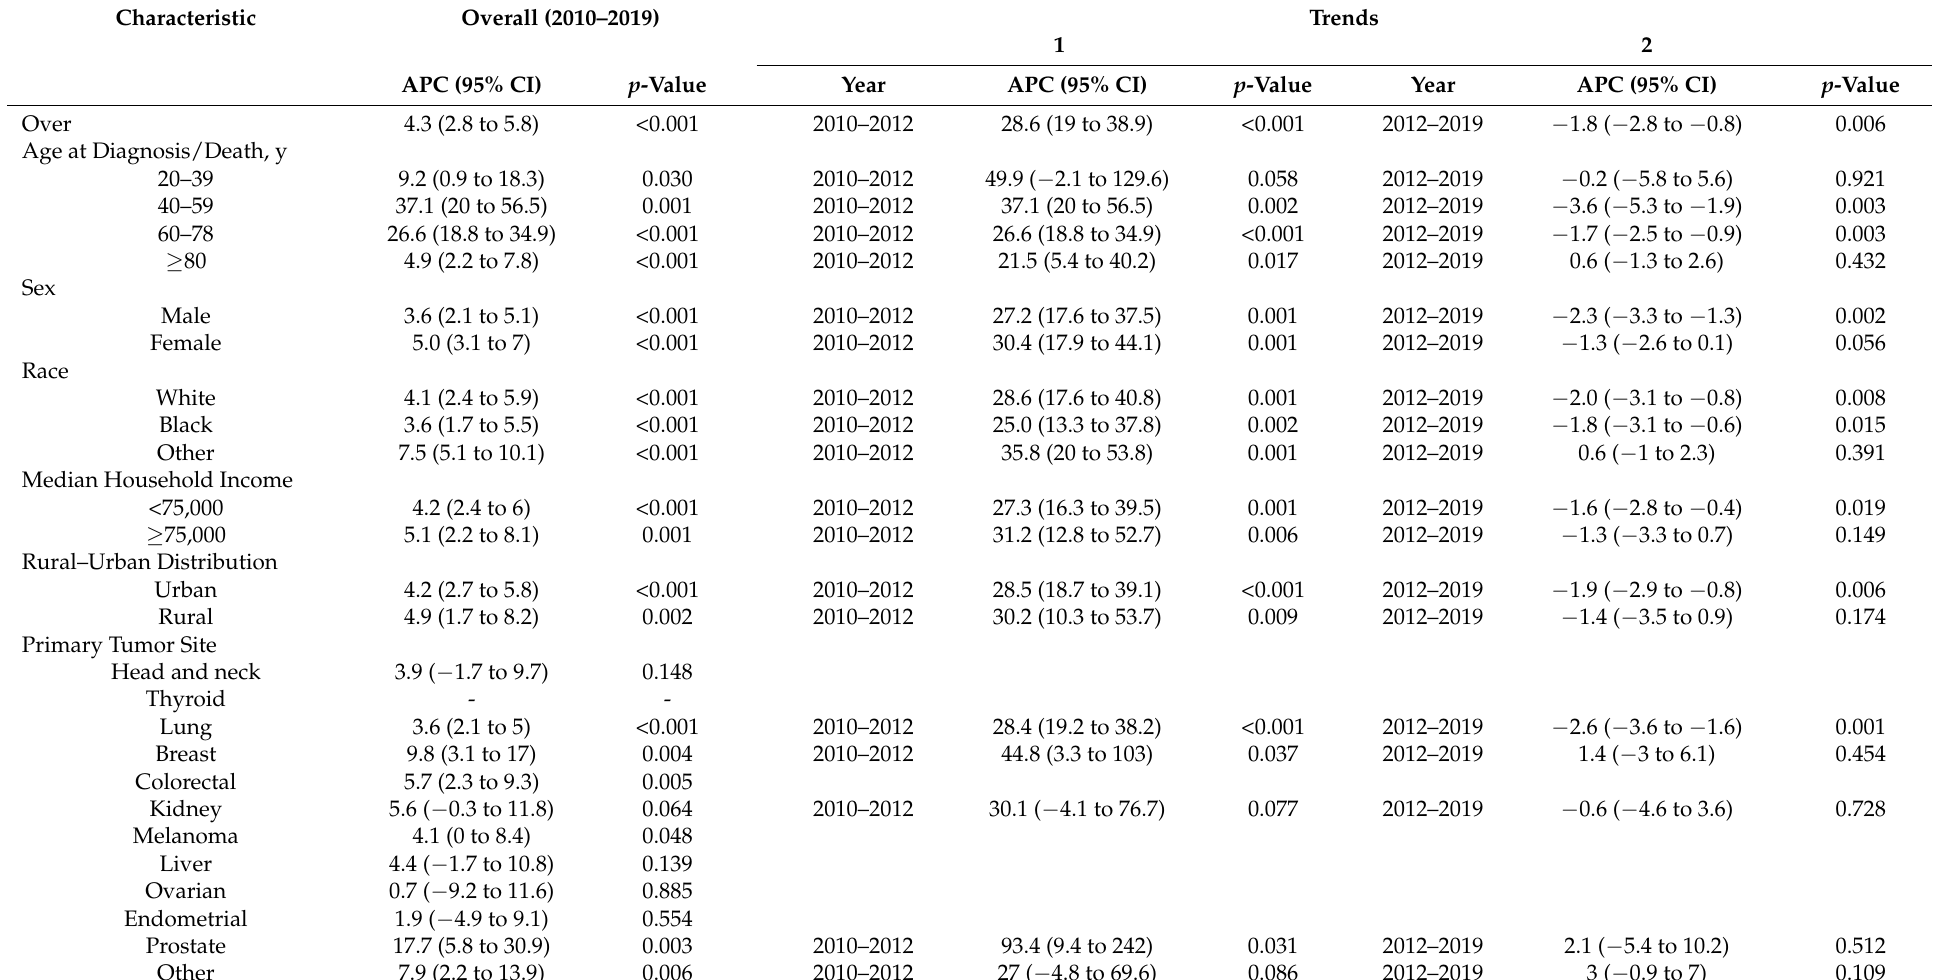
Table 3. Trends in SBM-incidence-based mortality rates* (2010–2019): the SEER-17 registry